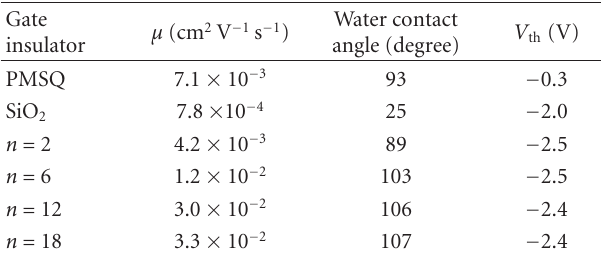
Table 2: Mobility ( μ ) and V th with respect to V G sweep of P3HT TFTs and water contact angle on di ff erent insulator surfaces. The alkyltrichlorosilane SAMs are represented as number of alkyl units ( n